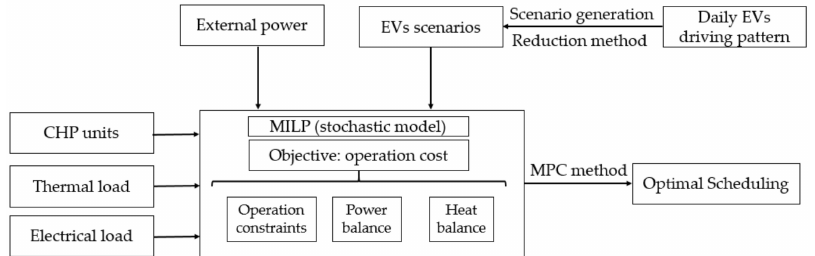
Figure 4. Schematic overview of the stochastic model predictive control (MPC) approach for MES scheduling optimization. MILP: mixed-integer linear